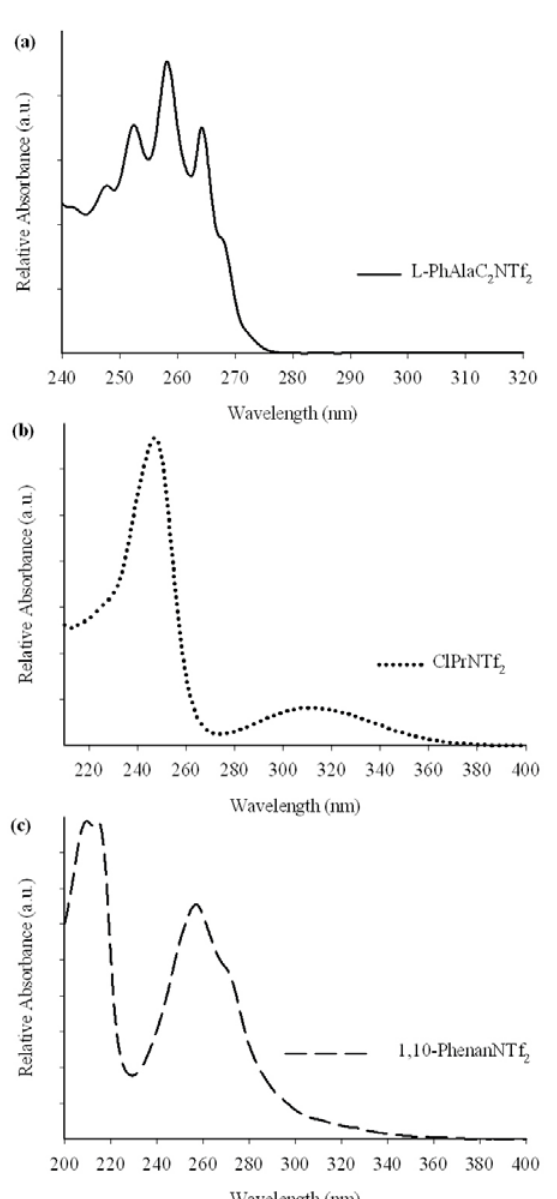
Figure 1. Thermal gravimetric analysis of (a) L-PhAlaC